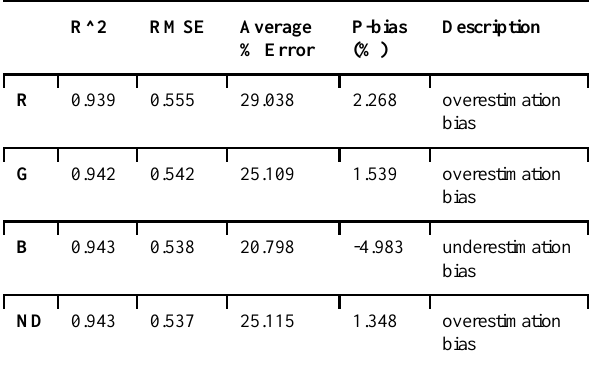
Table 2. Comparison of Quantitative Statistics of the all channel of camera red, green, blue and ND function against measured illuminance.